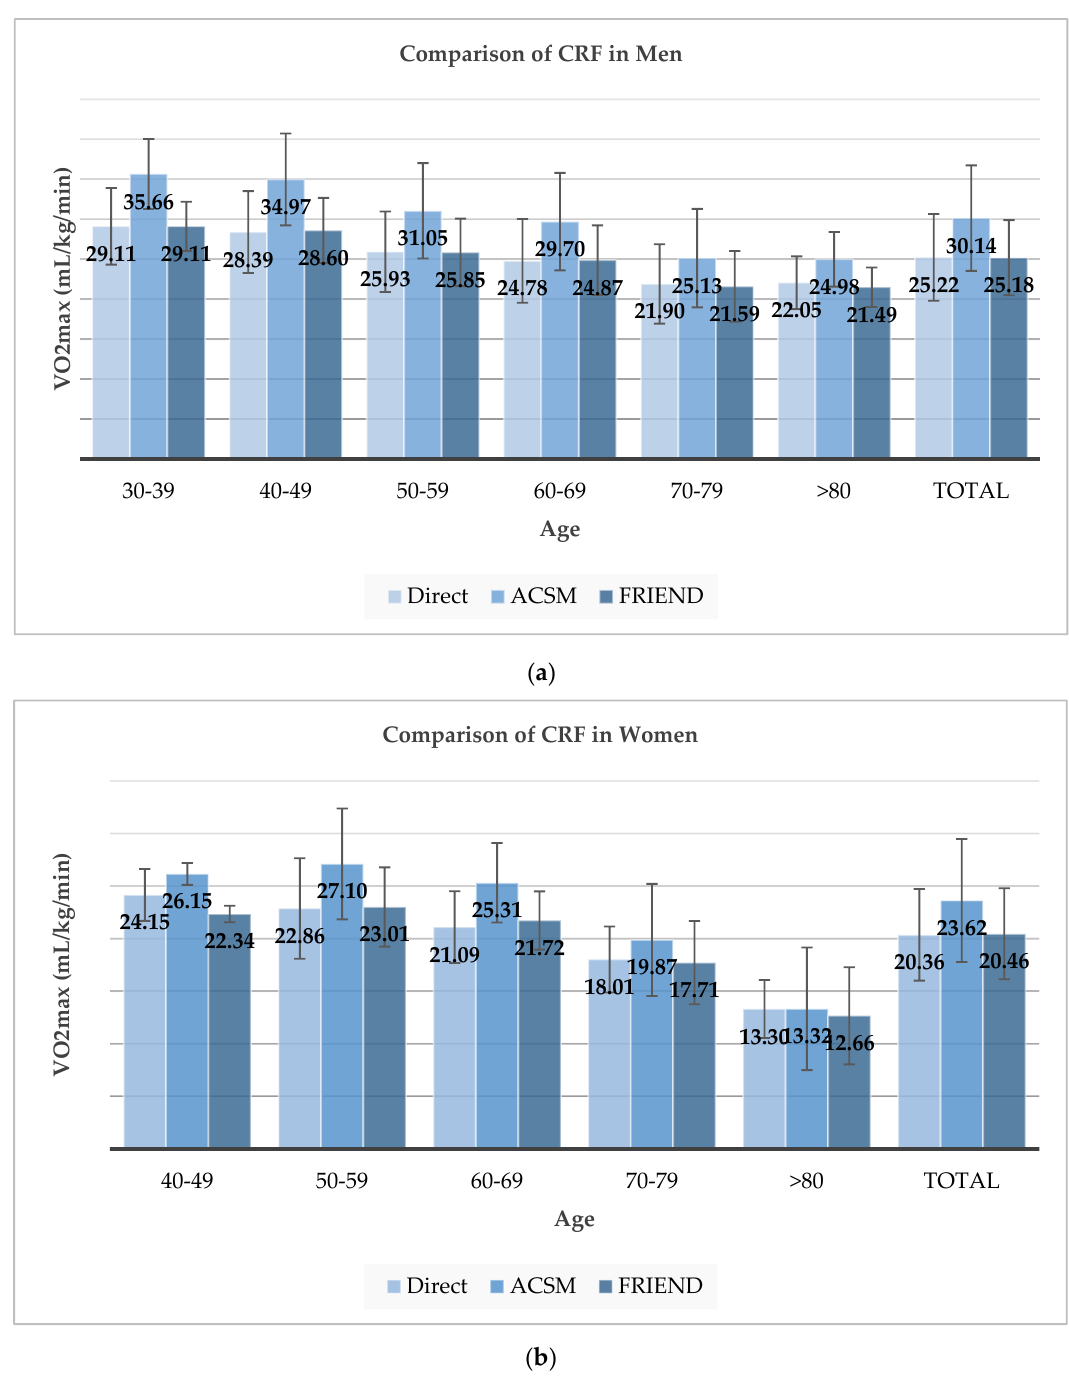
Figure 1. Comparison of cardiorespiratory fitness (CRF) between direct measured CRF and estimated CRF by American College of Sports Medicine (ACSM) and fitness registry and the importance of exercise national database (FRIEND) equation: ( a ) Comparison of CRF in men; ( b ) Comparison of CRF in women. Table 3. Comparison of CRF between directly measured CRF and estimated CRF, by ACSM equation and FRIEND equation.